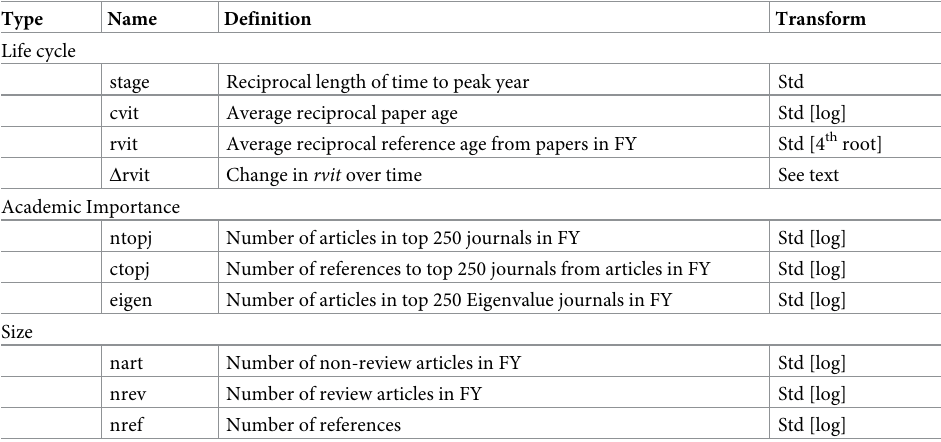
Table 4 focuses on the year right before the two models were built (RY = -1). For the DC5 model, there were 10,663 RCs as of 2011 that had their peak publication year in 2011. Of these Table 2. Indicators that were tested for prediction of exceptional growth (std = standardized; log = log